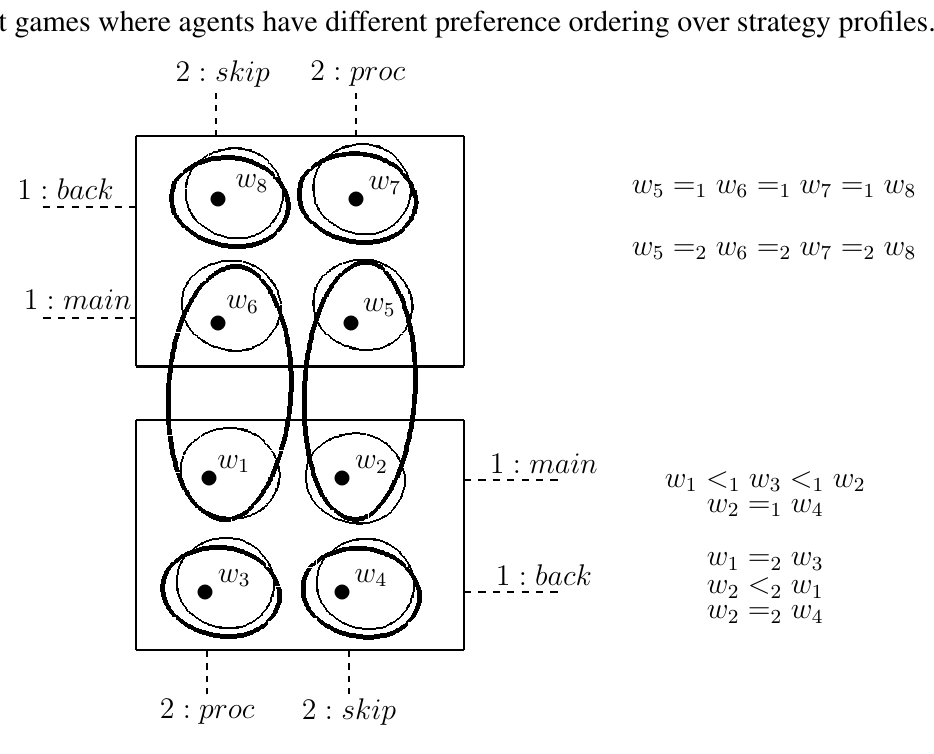
) = { w , w , w , w } and ∼ ( w ) = { w , w , w , w } correspond to 1 1 2 3 4 5 5 6 7 8